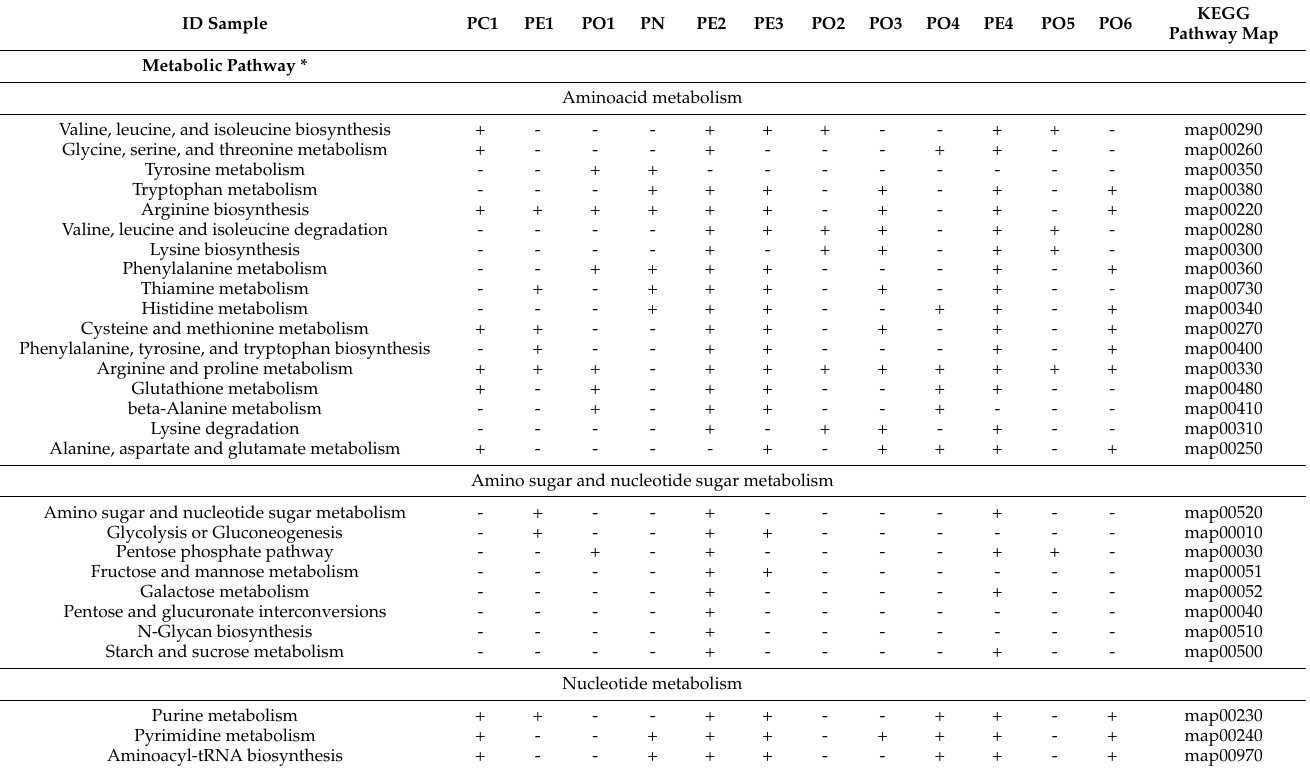
Table 5. Regulated (+) or unregulated (-) metabolic pathway between Pleurotus samples as an effect of the different growth